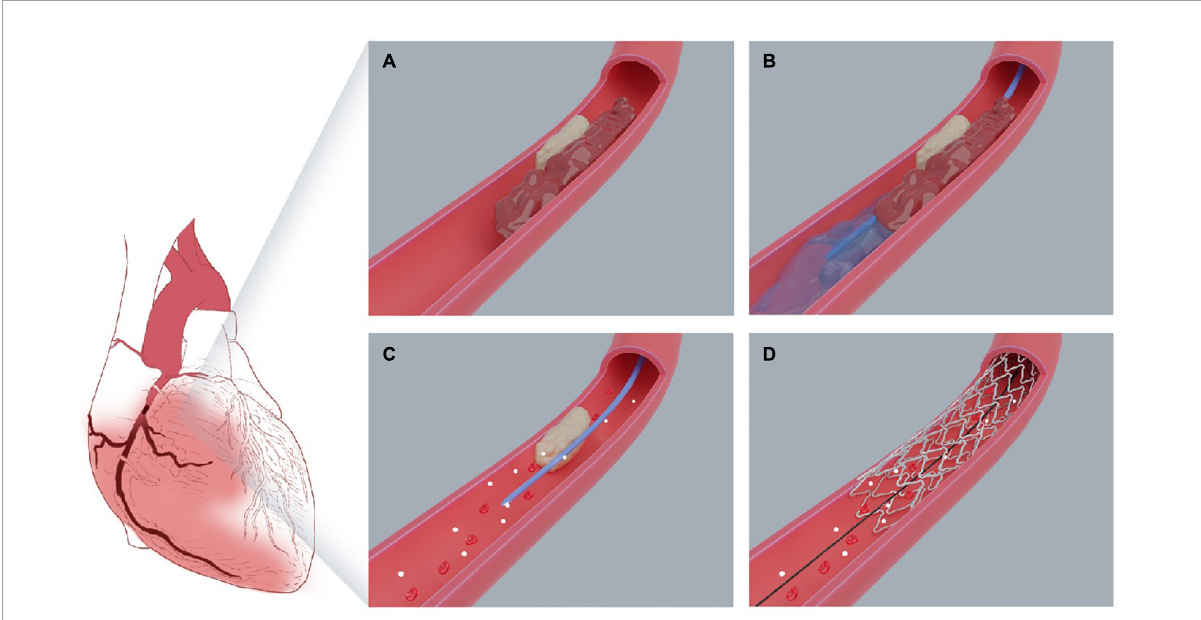
FIGURE2 Pattern diagram of intracoronary artery retrograde thrombolysis system. (A) The right coronary plaque ruptured, leading to thrombosis. (B) The sheared balloon was placed far away from the occluded segment, and the “visual thrombolytic agent” was slowly injected into the occluded site through the sheared balloon. (C) The occluded thrombus was completely dissolved and the blood flow recovered. (D) The stent was accurately implanted into the